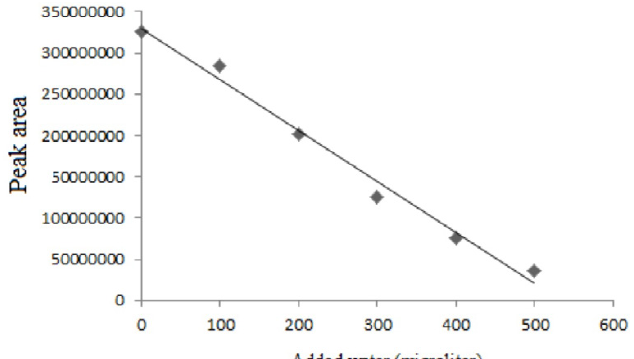
Fig. 2 . Effect of water addition on the extraction efficiency of the solid-phase microextraction